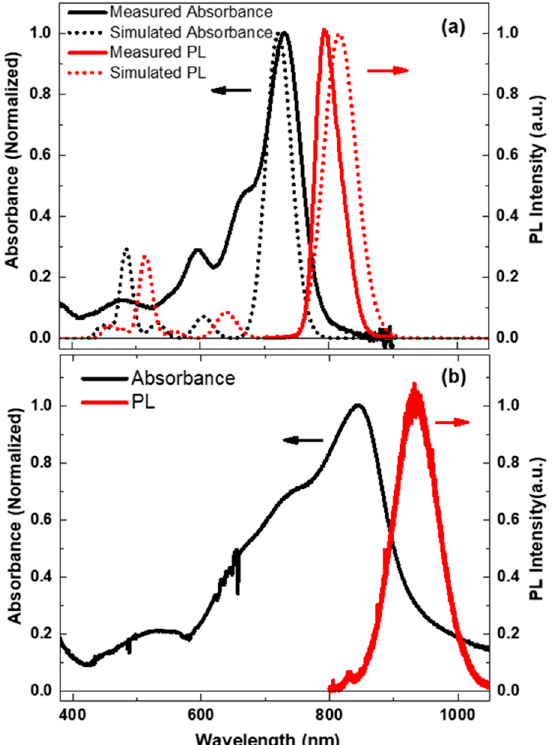
Figure 2. ( a ) Experimental measured (solid lines) and simulated (dot lines) absorption and fluorescence spectrum of Y6 in chloroform solution; the simulations were conducted by TD-DFT with B3LYP/6-31G*, and the vibration contribution was not included in the calculation. A Gaussian function with a full width at half-maximum (FWHM) of 0.11 eV was employed for the simulated spectrum. ( b ) Experimental measured (solid lines) absorption and fluorescence spectrum of Y6 film. The excitation wavelength of experimental measured fluorescence of Y6 solution and Y6 film was 600 nm and 700 nm, respectively.